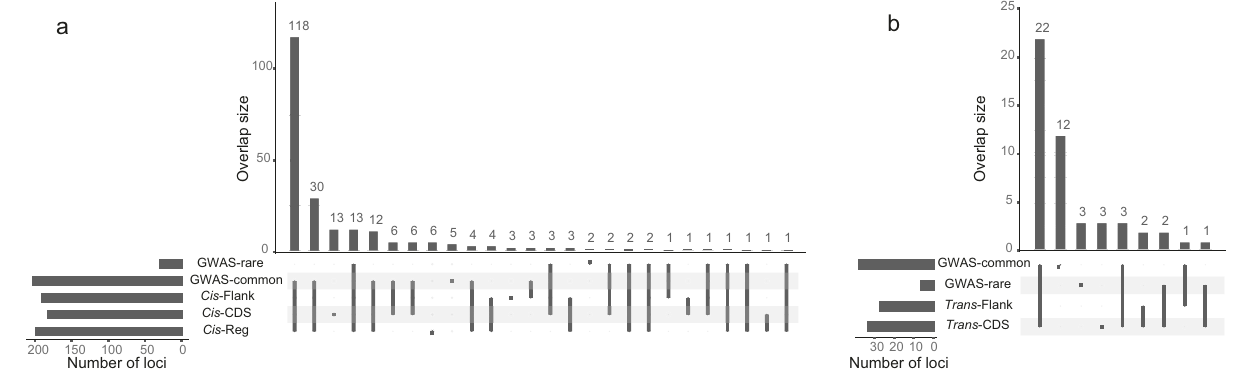
Fig. 4 Overlap between the identi fi ed loci for the different SNV-sets and the GWAS. The number of loci is the total number of independent loci identi fi ed with each SNV-set or GWAS, and the overlap size is the number of loci that overlaps between SNV-sets and GWAS for: a Cis -associations, and b Trans -associations. For the Cis -associations, a p -value (SKAT-test) of 5.88 × 10 ‑ 6 was considered as threshold for signi fi cance for the SKAT analyses, and a p -value (Wald-test) of 3.00 × 10 − 8 for the GWAS. For Trans -associations, a p -value (SKAT-test) of 4.67 × 10 − 10 was considered as threshold for signi fi cance for the SKAT analyses, and a p -value (Wald-test) of 3.92 × 10 − 11 for the